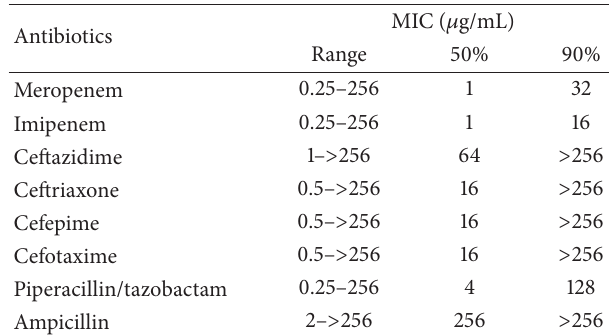
Table 2: Minimum inhibitory concentration of different antibiotics against 83 K. pneumoniae